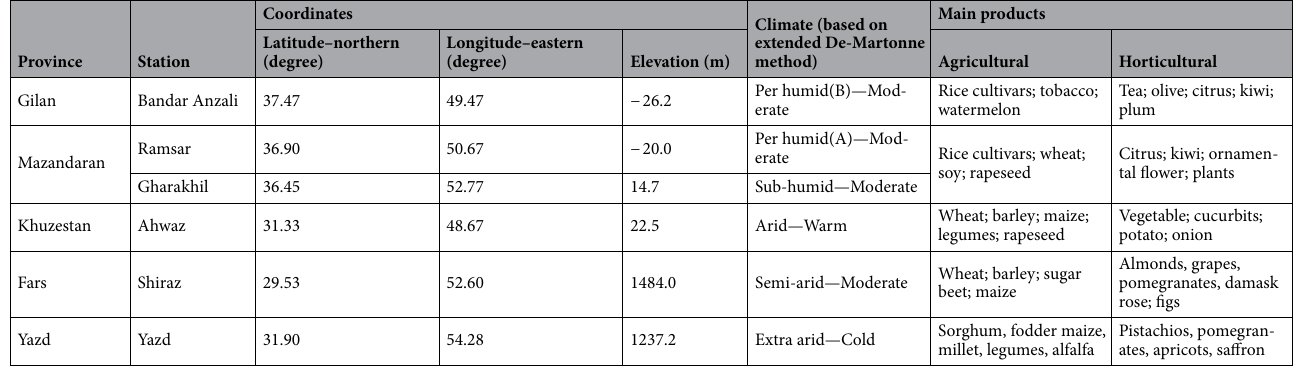
Table 1. The studied stations’ location, climate (according to extended De-Martonne classification) and the main agricultural/horticultural products of their